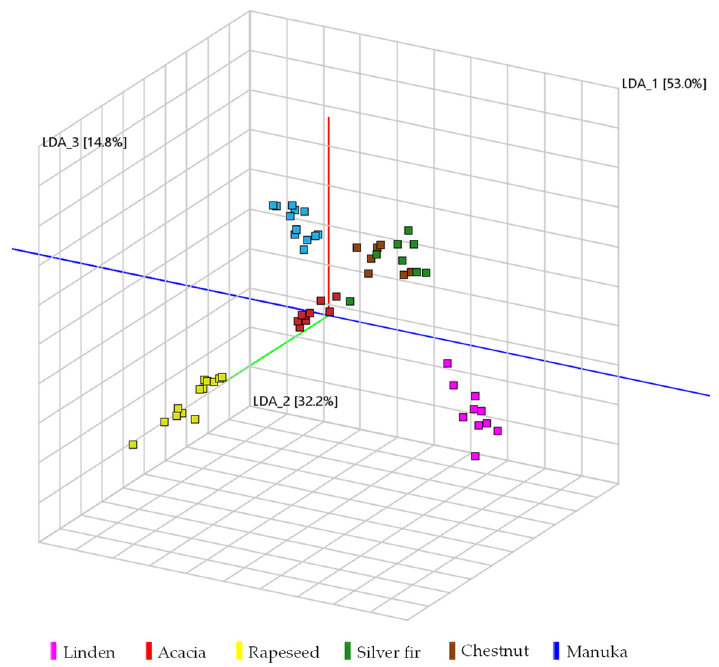
Figure 4. Three-dimensional visualization of principal component analysis with linear discriminant analysis (PCA-LDA) of the honey data set with samples grouped by color as honey type (linden = pink, acacia = red, rapeseed = yellow, silver fir = green, chestnut = brown, and manuka = blue).